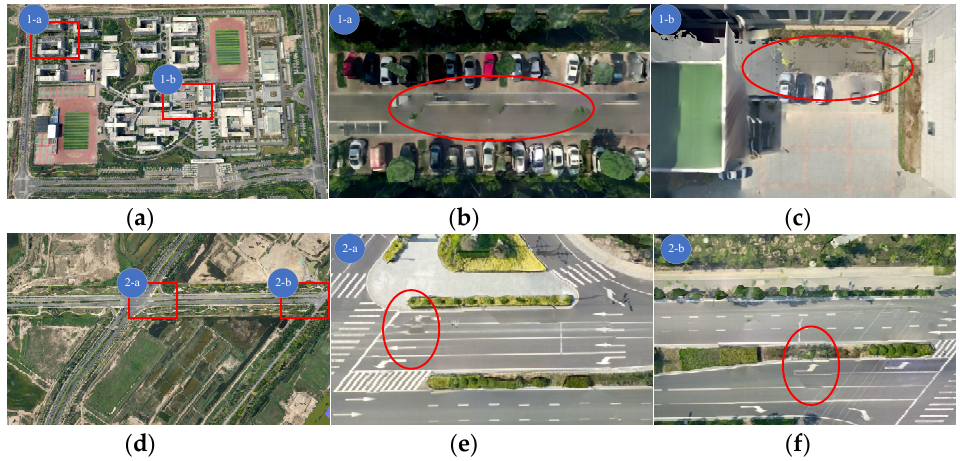
Figure 14. Texture reconstruction results obtained via the Waechter algorithm. ( a ) texture results for building area; ( b,c ) the texture reconstruction result of building area via Waechter method; ( d ) texture results for nonbuilding area; ( e , f ) the texture reconstruction results of nonbuilding area via Waechter method. red frame is the local detail area; red circle is the experimental comparison area.